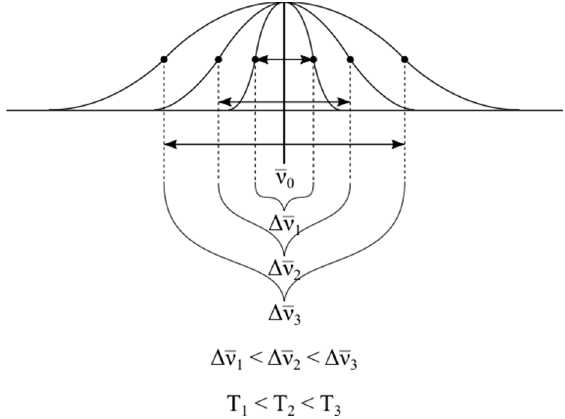
Figure 7. Doppler thermally broadened luminescence spectra. Spectral bandwidths are measured at half-maximum intensity in wavenumbers (cm − 1 ).